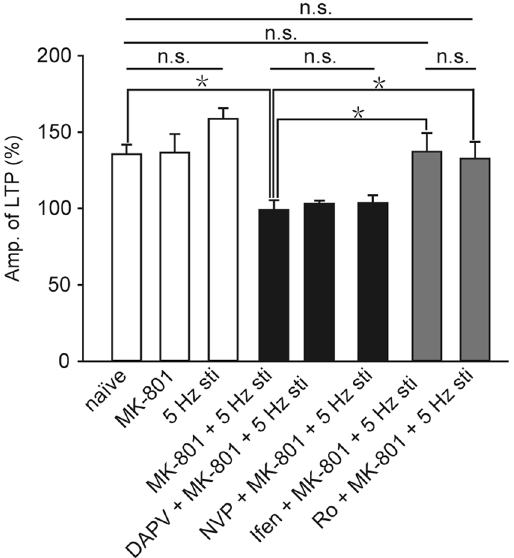
Figure 5. Comparison of LTP values among different experimental groups. Naïve, n = 4; MK-801, n = 6; 5 Hz stimulation, n = 11; MK-801 and 5 Hz stimulation, n = 9; DAPV, MK-801 and 5 Hz stimulation, n = 4; NVP, MK-801 and 5 Hz stimulation, n = 6; Ifen, MK-801 and 5 Hz stimulation, n = 6; Ro, MK-801 and 5 Hz stimulation, n = 5. All data points represented as mean ± SE, * p < 0.05.